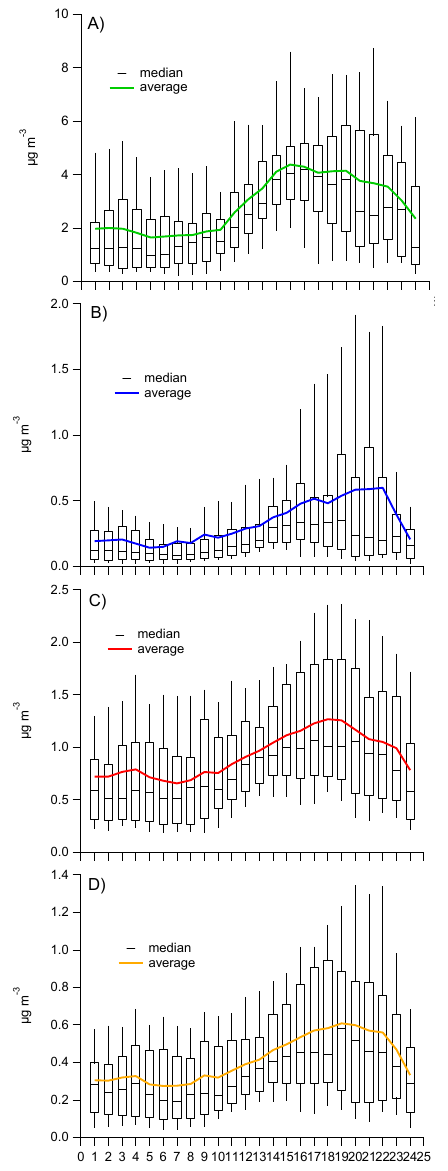
Figure 3. Daily trends of (a) organics, (b) nitrate, (c) sulfate and (d) ammonium. Boxes represent median, 25th and 75th per- centile; whiskers indicates 10th and 90th percentile. Time is local (UTC + 2h).